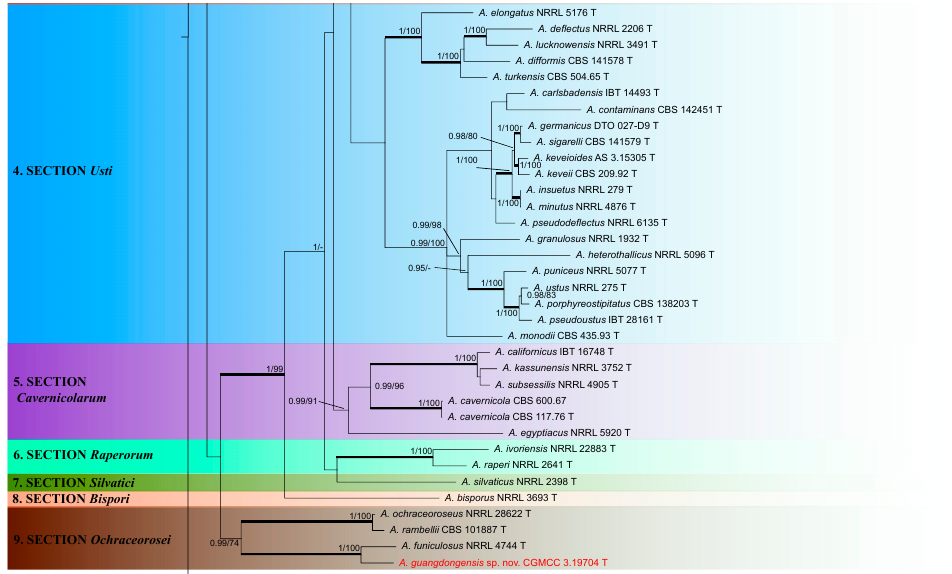
Figure 1. Phylogenetic tree of subgenus Nidulantes inferred from concatenated four loci: ITS, BenA , CaM and RPB2 . Branches with values more than 1.00 pp and 95% bs are thickened. The phylogram is rooted with Aspergillus flavipes NRRL 302 T. T = ex-type.